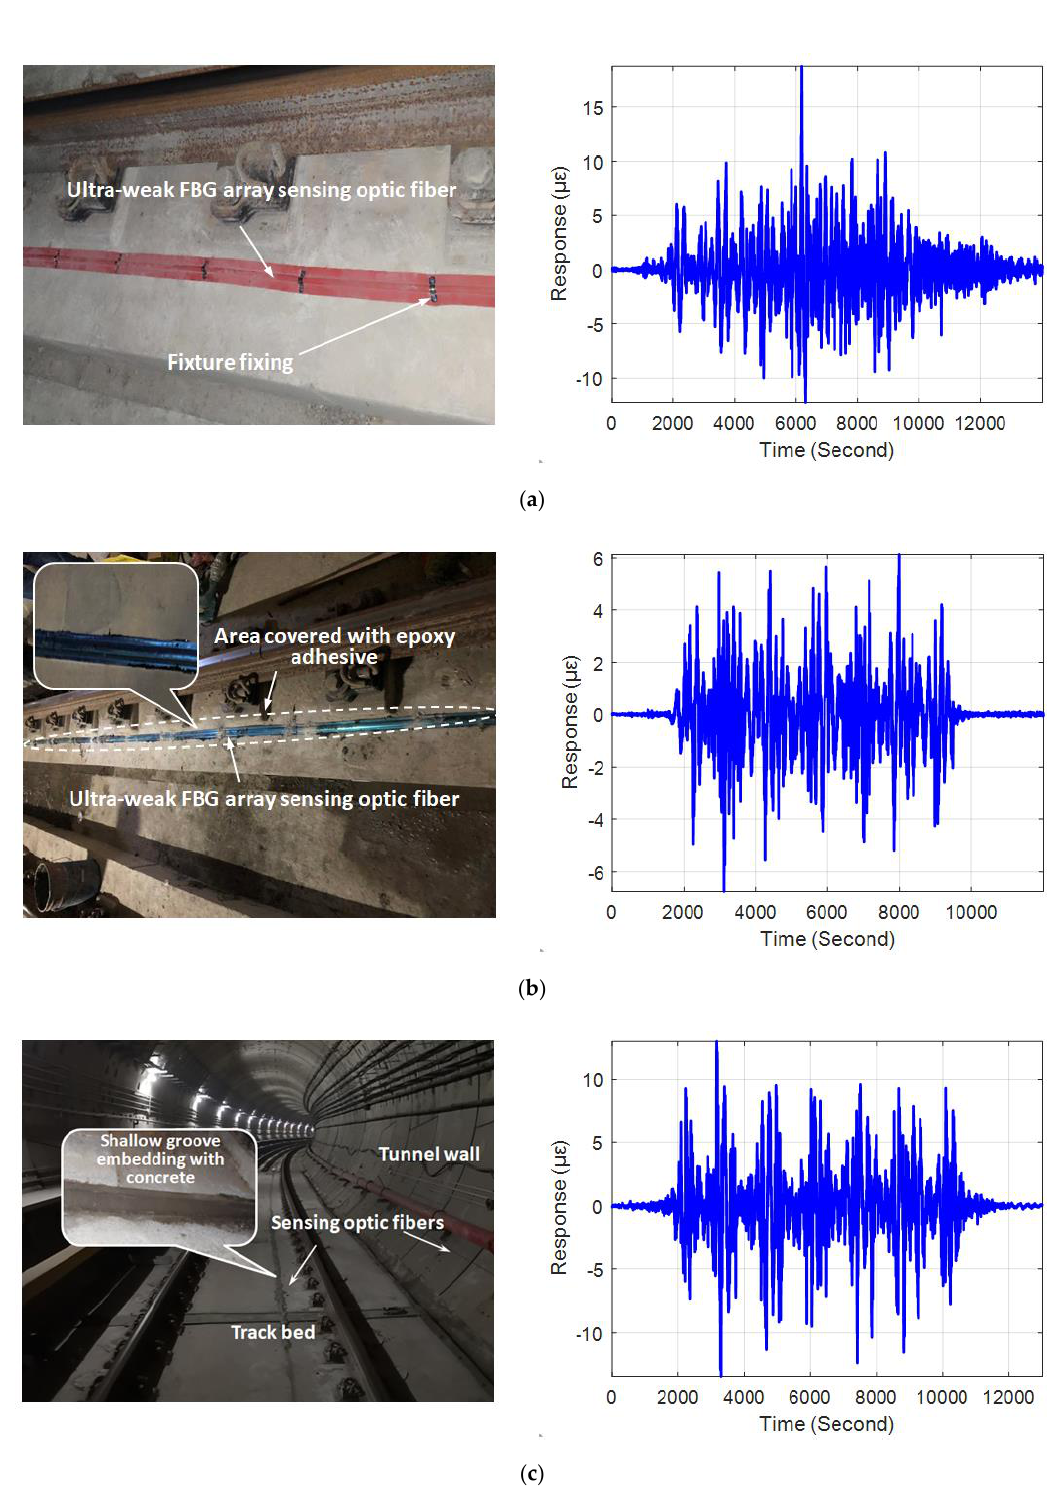
Figure 3. Methods of affixing distributed vibration sensing optic fibers and typical vibration response induced by train: ( a ) fixture fixing, ( b ) epoxy adhesive, and ( c ) shallow groove embedding.